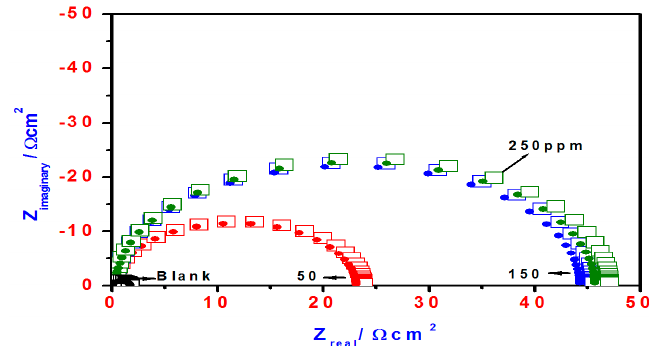
Figure 5. The influence of T3Q concentrations on the the Nyquist plots of steel in acidic chloride solution.